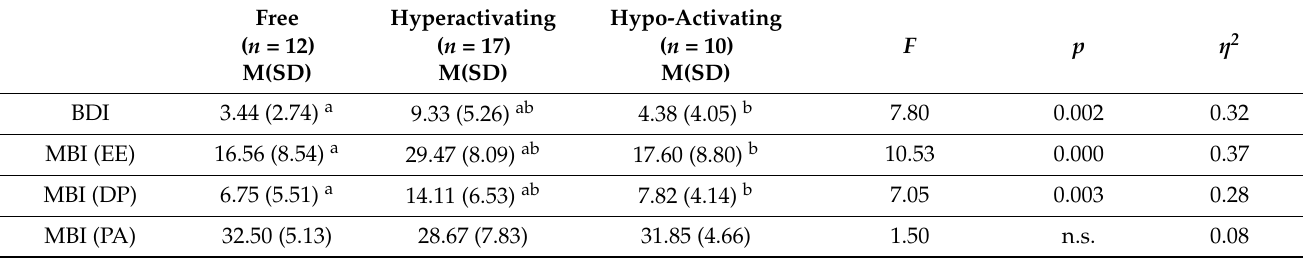
Table 5. Depression and burnout symptoms: comparison among free, hypo-activating and hyperactivating methods (one-way ANOVA) POs ( n =